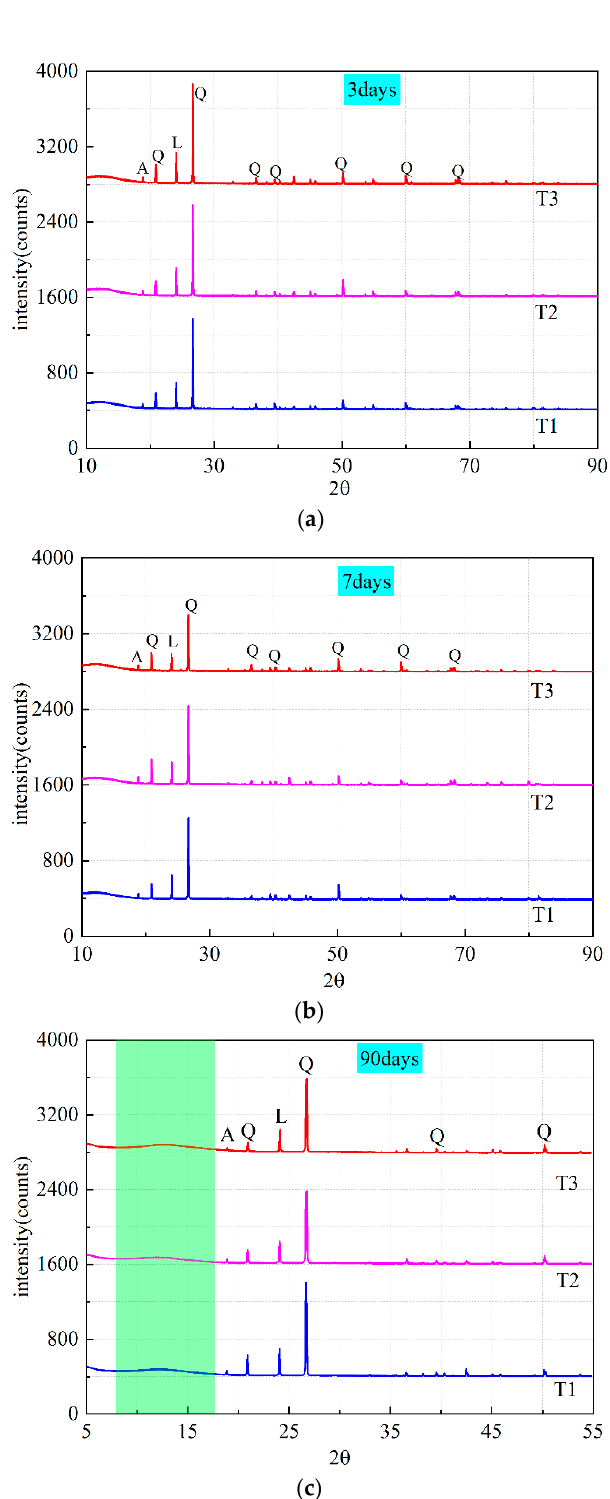
Figure 9. XRD patterns of samples (T1, T2, T3) at different ages (Q-quartz, A-amarillite, L-lazurite): ( a )